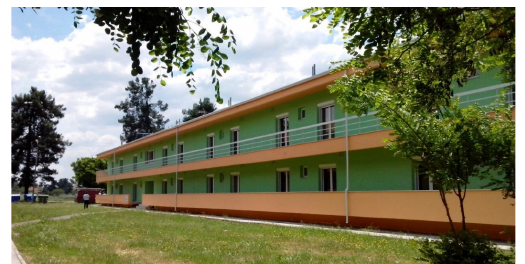
Figure 3. The test building and the landscape surrounding area